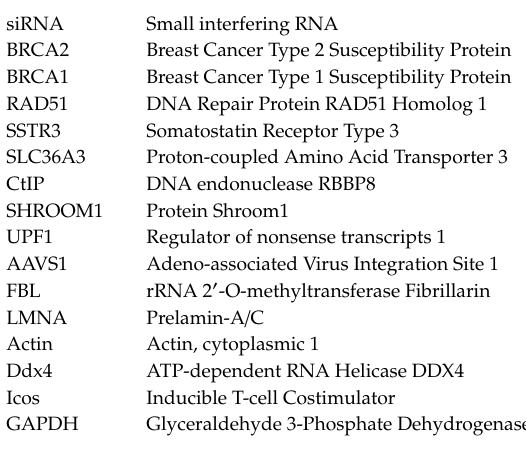
Figure S1: Construction of iDR-U2OS reporter cells. Figure S2. Performances of paired crRNAs and the dual-cut BFP reporter guarantees feasibility of the screening. Figure S3. Validation of the representative genes demonstrates the reliability of crRNA screening in dual-cut BFP reporter cells. Figure S4. Knockdown of SHROOM1 mediates precise target editing after incision by CRISPR / Cas9 in vitro. Figure S5. Knockdown of SHROOM1 promotes precise target editing after incision by CRISPR / Cas9 in mouse embryos. Table S1: Gene sequences used in this study (5 (cid:48) -3 (cid:48) ). Table S2. Primer sequences used in this study (5 (cid:48) -3 (cid:48) ). Table S3. siRNA, sgRNA target and crRNA target sequences used in this study (5 (cid:48) -3 (cid:48) ). Table S4. Genome wide screening results. Table S5. CRISPR screening gene list and screening results. Table S6. All values used in